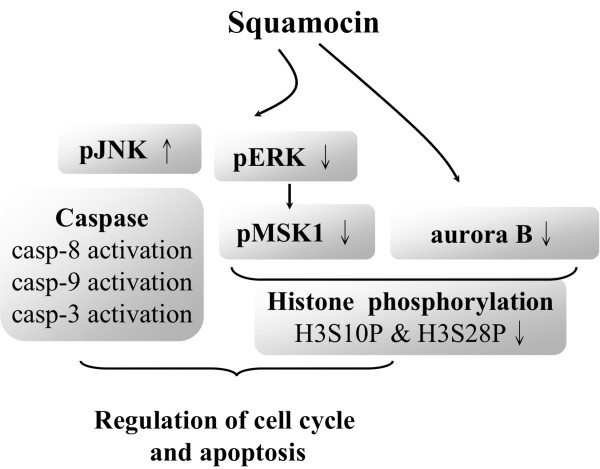
Hypothetical schematic diagram of squamocin-induced cell cycle arrest and apoptosis in cancer cells. Based on our results, squamocin could induce the activation of JNK and caspases, and decrease the phosphorylation levels of H3S10 and H3S28 by downregulating the expression of pERK, pMSK1, and aurora B. We proposed the hypothesis that histone dephosphorylation and activation of JNK and caspases contribute to squamocin induced cell cycle arrest and apoptosis.